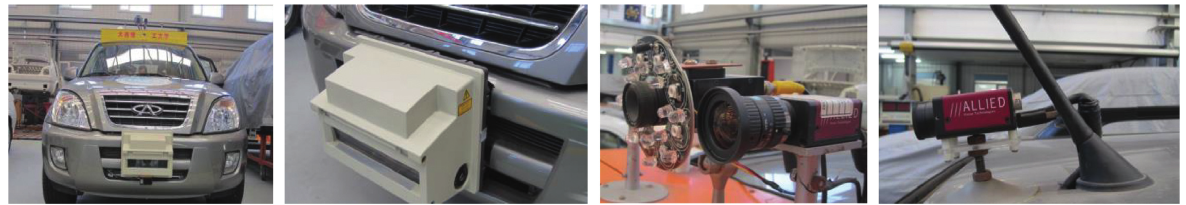
Figure 15: Intelligent vehicle with laser and vision